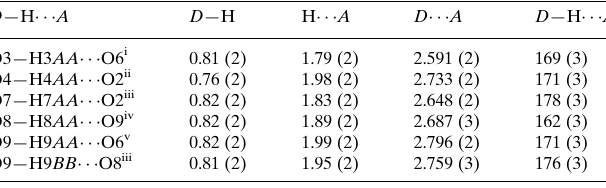
Hydrogen-bond geometry (A˚ , (cid:4)